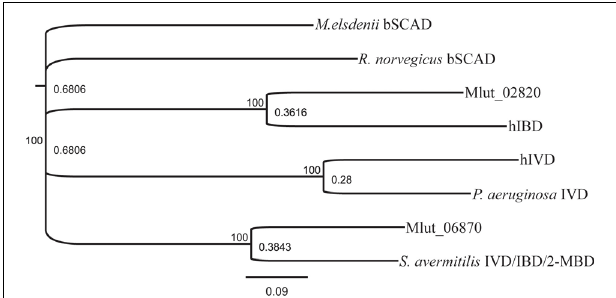
FIGURE 5 | Similarity tree derived from amino sequence alignment of short-chain acyl-CoA- dehydrogenases. The sequences used are candidates found in the genome of M. luteus and selected, well-described examples from the literature. GenPept sequence record numbers are: S . avermitilis IVD/IBD/2-MBD, AAD44196; R. norvegicus bSCAD, AAA40669; Mlut_02820, ACS29839; hIBD, NP_055199; hIVD, 1IVH; P. aeruginosa IVD, NP_250705; Mlut_06870, ACS30219; M. elsdenii bSCAD, 1BUC. Alignment was performed using Clustal Omega with a Blosum62 matrix. Conversion in a phylogenetic tree was done in Geneious using bootstraping with 1000